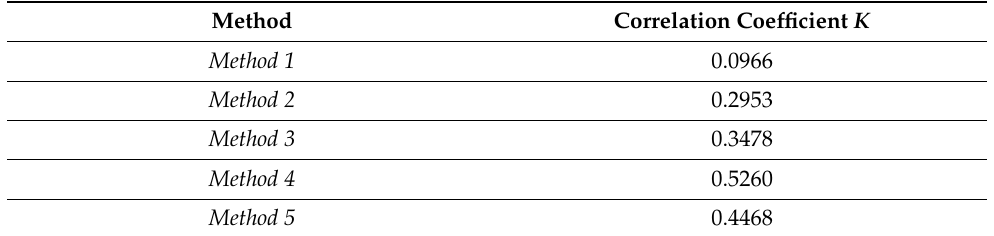
Table 5. Correlation coefficients between the individual heat costs in relation to the average value ( W ) and the average indoor temperature for the analysed methods of variable heat costs